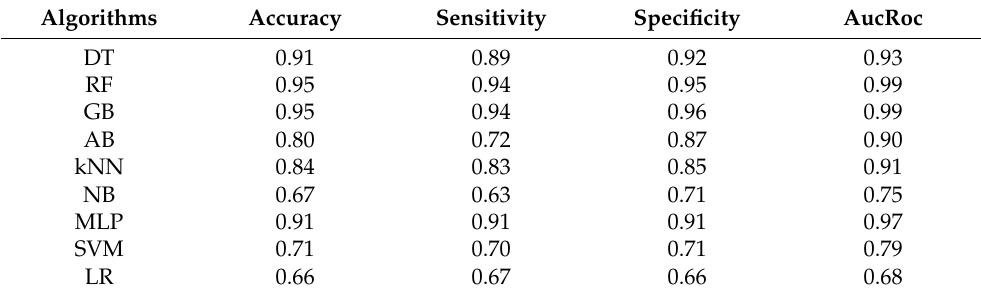
Table 5. Scores from stratified tenfold CV evaluation metrics considering the entire study sample and using the features extracted from both acceleration and angular velocity signals along the three axes with a non-zero IG. Algorithms Accuracy Sensitivity Specificity